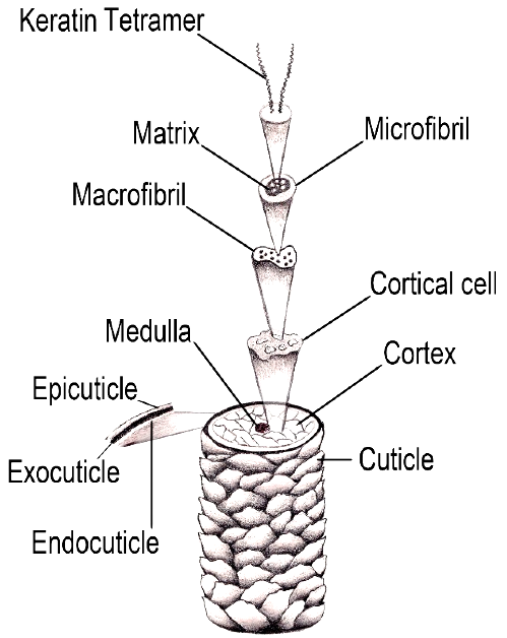
Figure 1. Sketch representing the hierarchical structure of a hair fiber. Reprinted from [3] under a Creative Commons Attribution 4.0 International